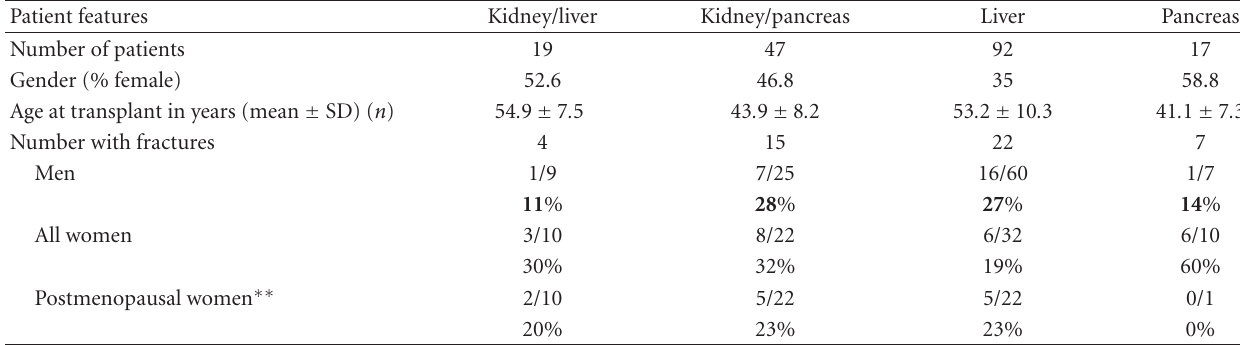
Table 1: Characteristics of organ transplant recipients and patients with fractures.